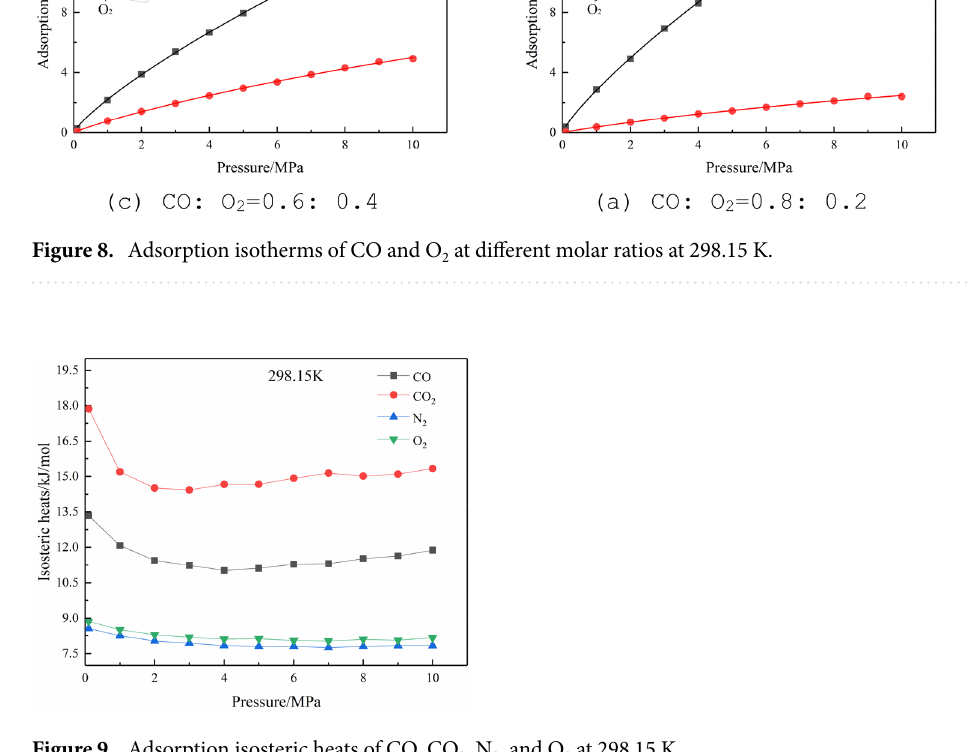
Figure 9. Adsorption isosteric heats of CO, CO 2 , N 2 , and O 2 at 298.15